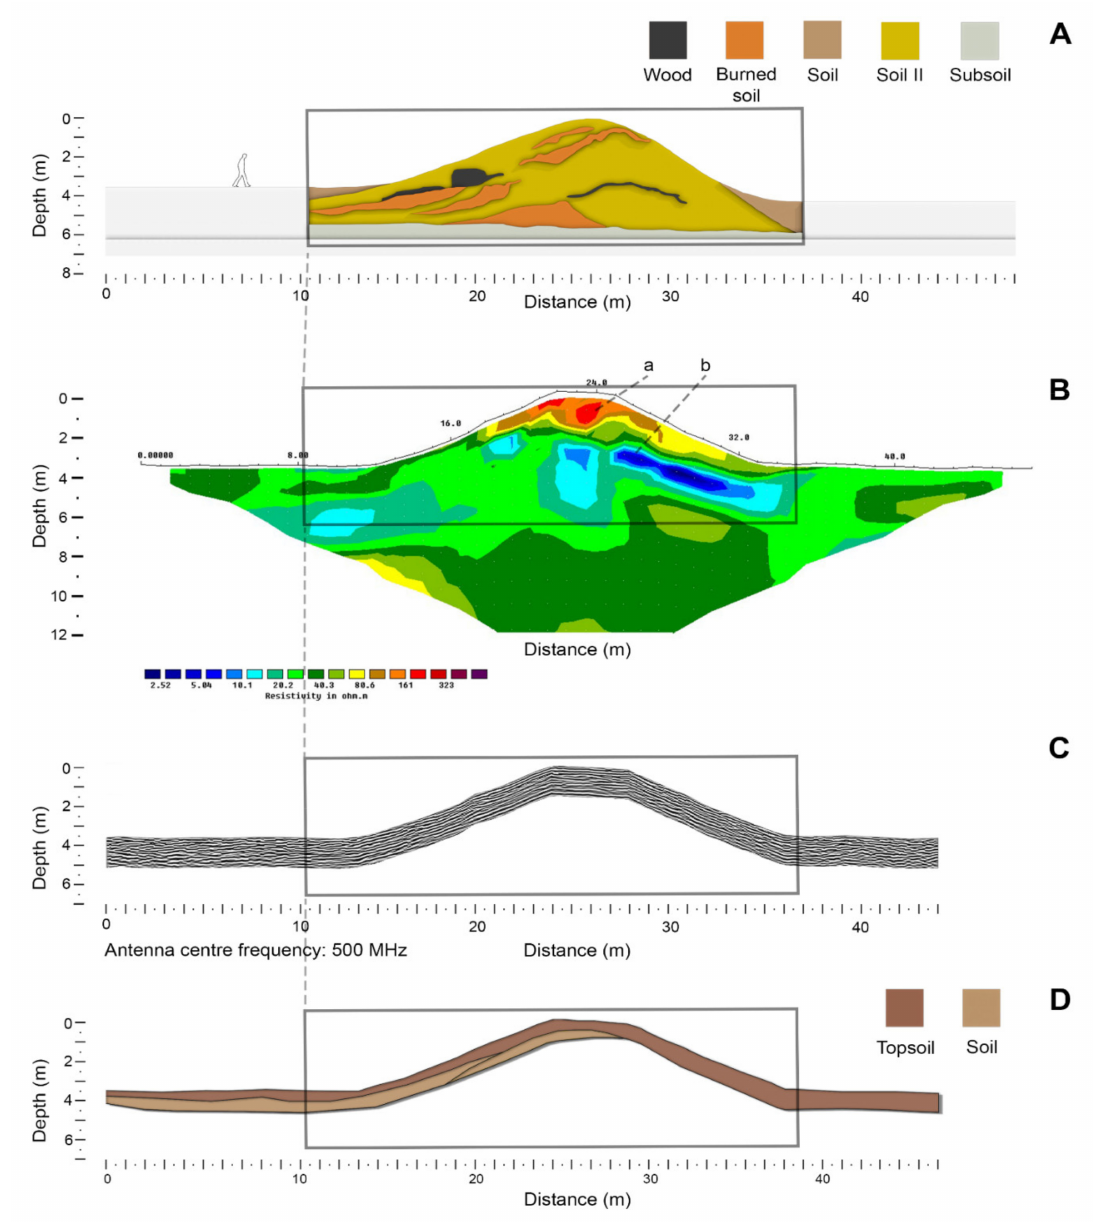
Figure 8. Doln í Vˇesonice-Vysok á zahrada. ( A ): Profile of the hillfort’s fortification based on the results of archaeological excavation ([9], Figure 77). ( B ): Electrical resistivity tomography model in double dipole configuration. ( C ): GPR vertical time/depth radarogram from an antenna with 500 MHz centre frequency. ( D ): Interpretation of the GPR